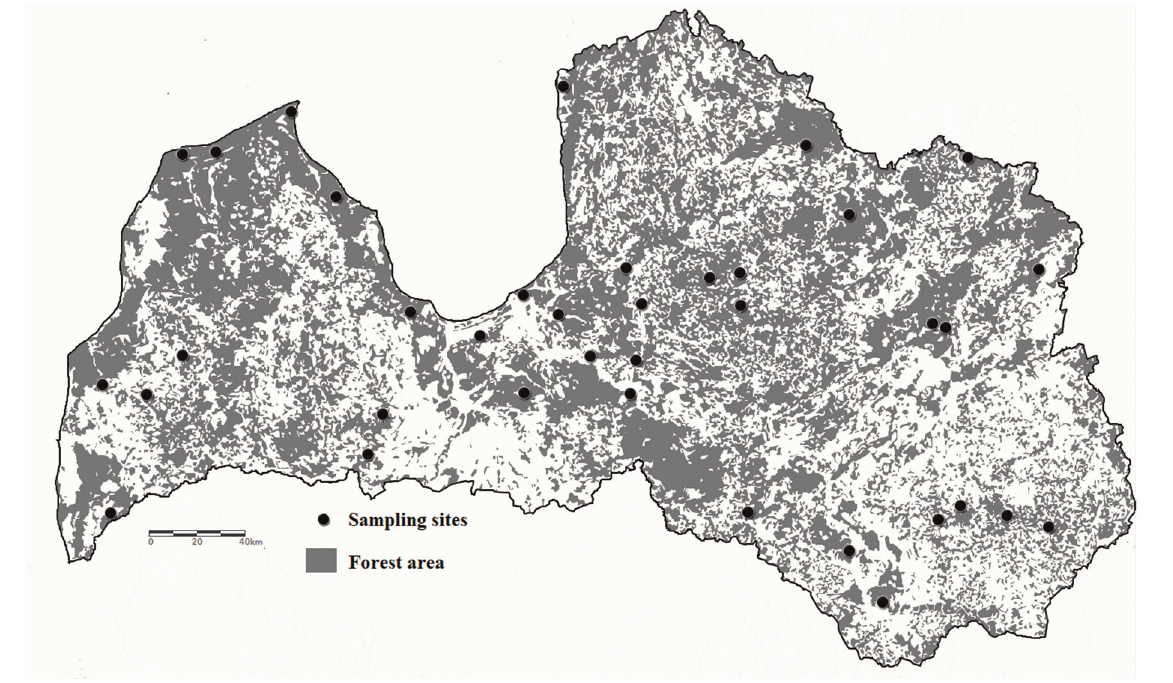
Fig. 1. Location of sampling sites in